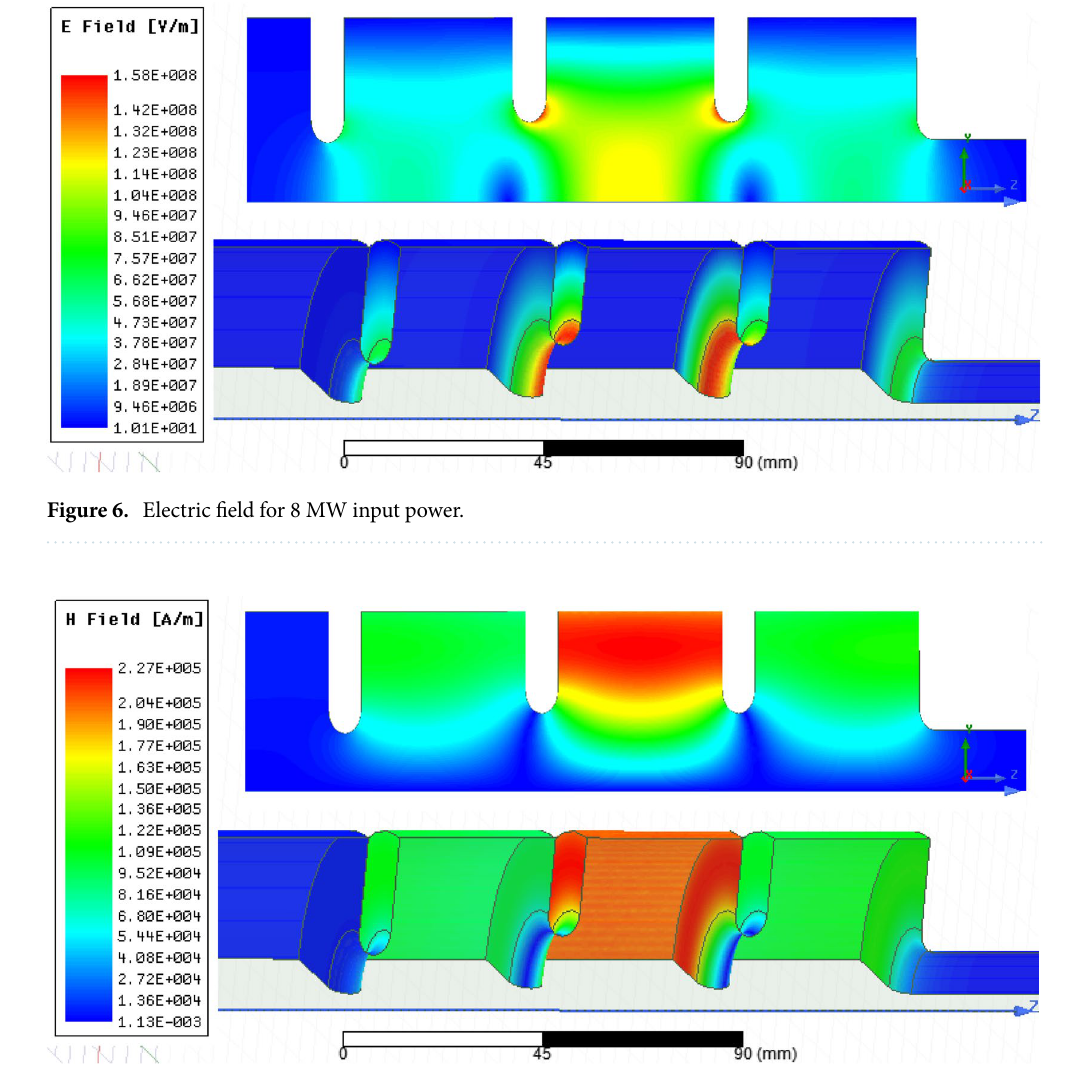
Figure 7. Magnetic field for 8 MW input